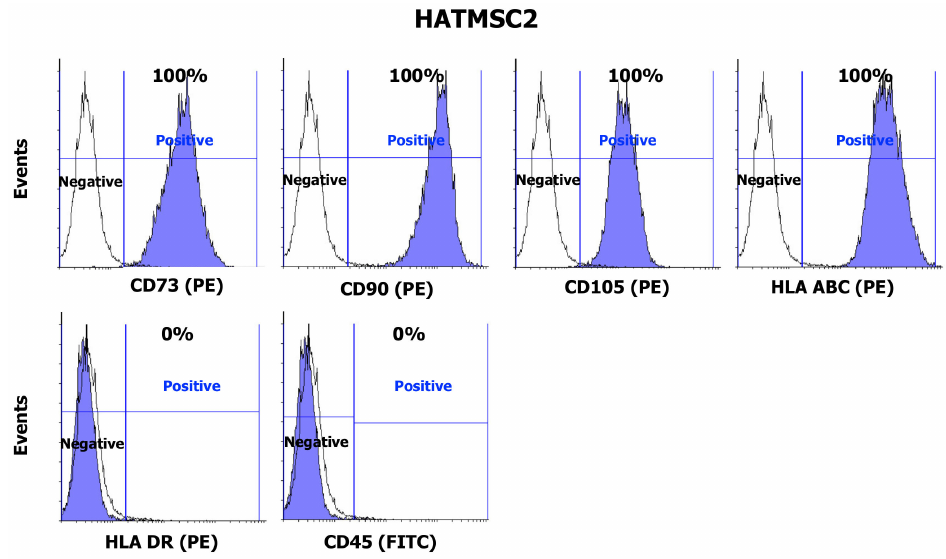
Figure 1. Characteristics of HATMSC2-MVs ( a ) Representative HATMSC2-MV size distribution histogram obtained using dynamic light scattering analysis. ( b ) Representative transmission electron microscopy image of HATMSC2-MVs, bars represent 500 nm. ( c ) Representative dot plot showing forward scatter (FSC) vs. side scatter (SSC). Gate R-1 shows the population of HATMSC2-MVs, and gate R-2 represents the counting beads. HATMSC2-MVs—microvesicles derived from immortalized human mesenchymal stem cells of adipose tissue